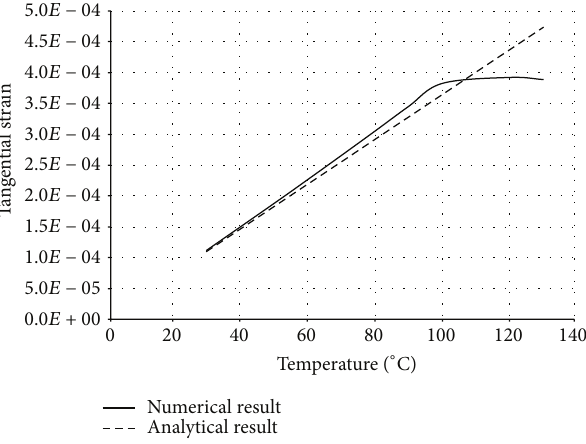
Figure 24: Comparison of tangential strain in steel